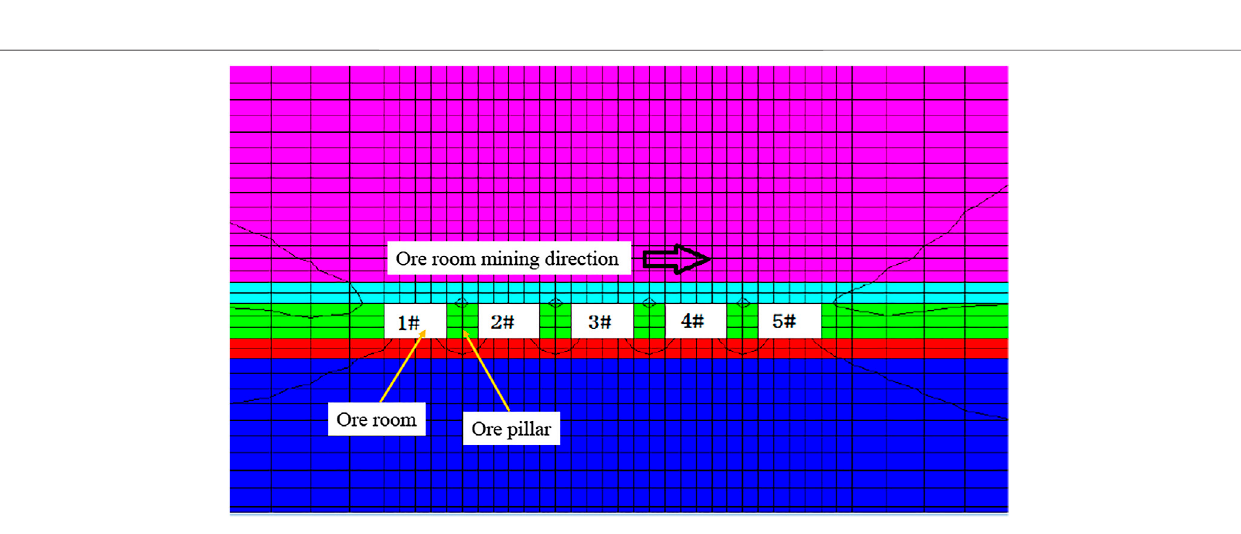
FIGURE 3 | Layout of ore rooms along the